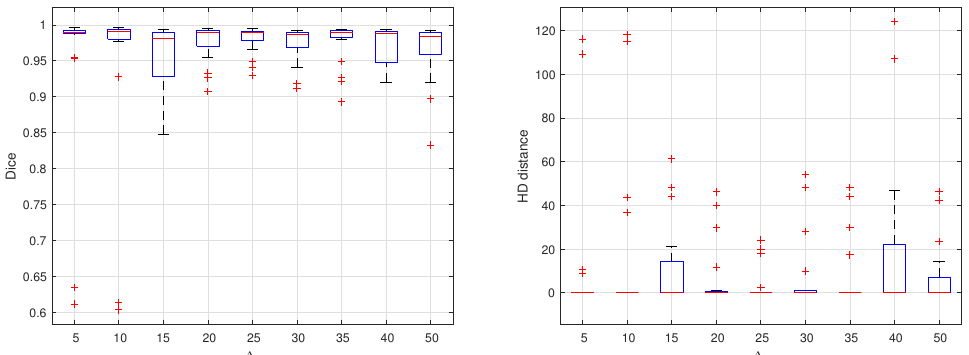
Figure 4. Effect of changing delta on segmentation accuracy evaluated by computing DC and HD distance for different empirically selected